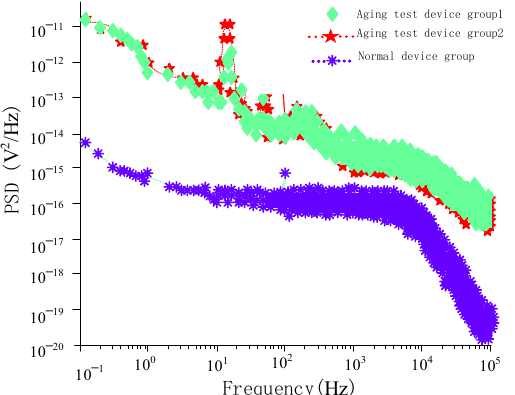
7 of 13 Figure 3. IGBT low-frequency noise detection scheme. Figure 4. IGBT low-frequency noise test environment.